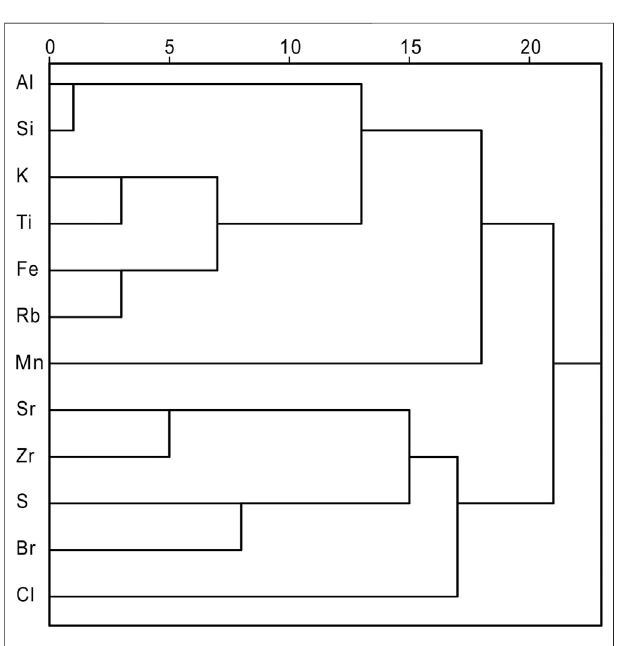
FIGURE5| Treecluster analysisofelements,based